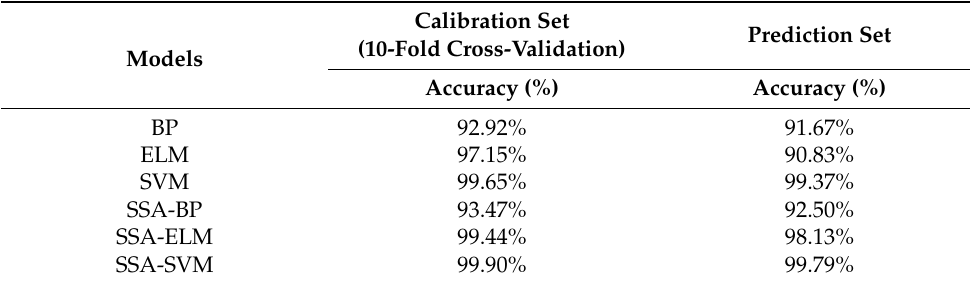
Table 1. The discrimination results in each data set using the basic models and the optimisation models.